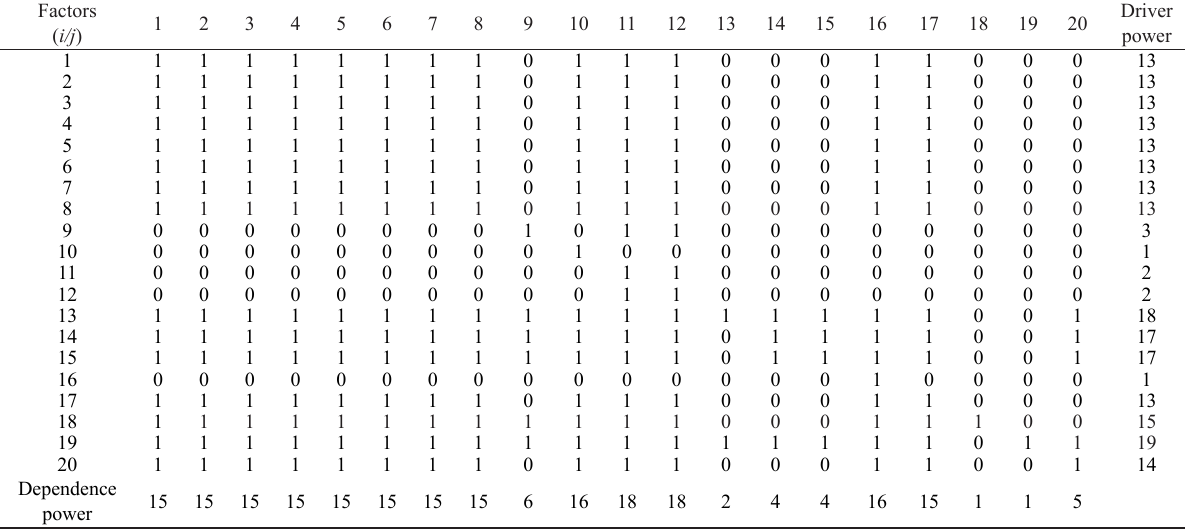
Table 5. Reachability Matrix of critical success factors Factors ( i/j )